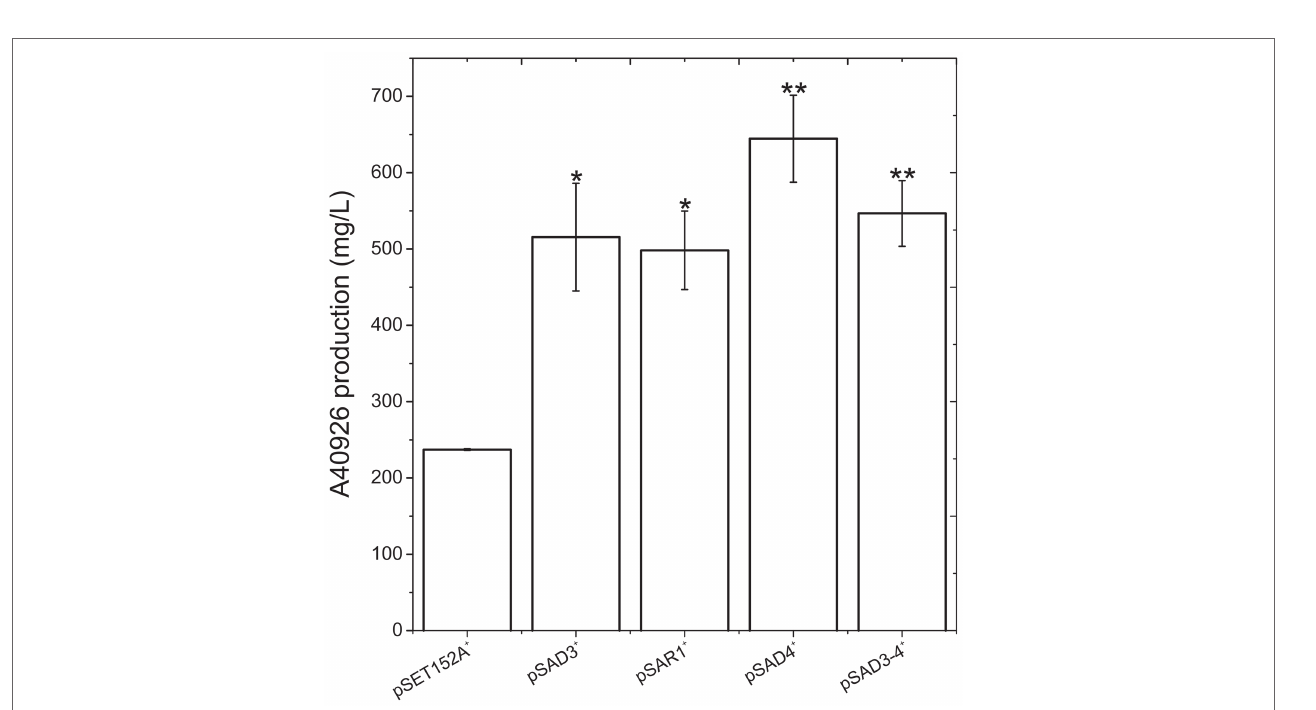
FIGURE 3 | A40926 production in N. gerenzanensis carrying the empty vector pSET152A + and in its recombinant strains overexpressing dbv3 (pSAD3), nocRI (pSAR1), dbv4 (pSAD4), and co-expressing dbv3 and dbv4 genes (pSAD3–4) cultivated in FM2 industrial medium at 500 ml Erlenmeyer flasks-scale. A40926 production was measured after 120 h of cultivation. The results given represent three independent fermentations, error bars represent standard deviations. Statistical significance of the differences in A40926 production between the control and the recombinant strains was estimated using Welch’s t -test: * p < 0.05; ** p <